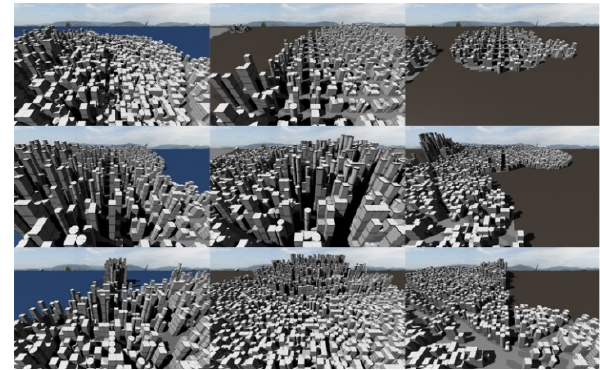
Figure 5. Generation 1 of an IGA